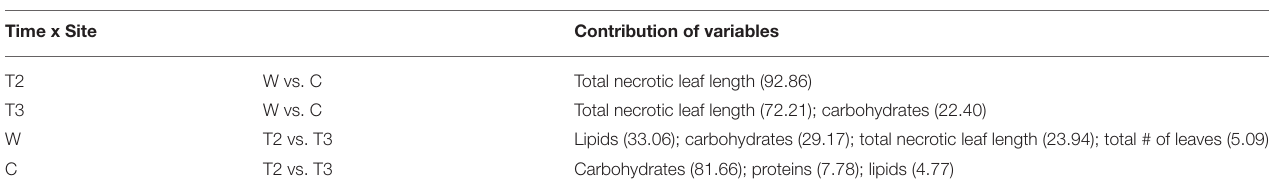
TABLE 2 | Current